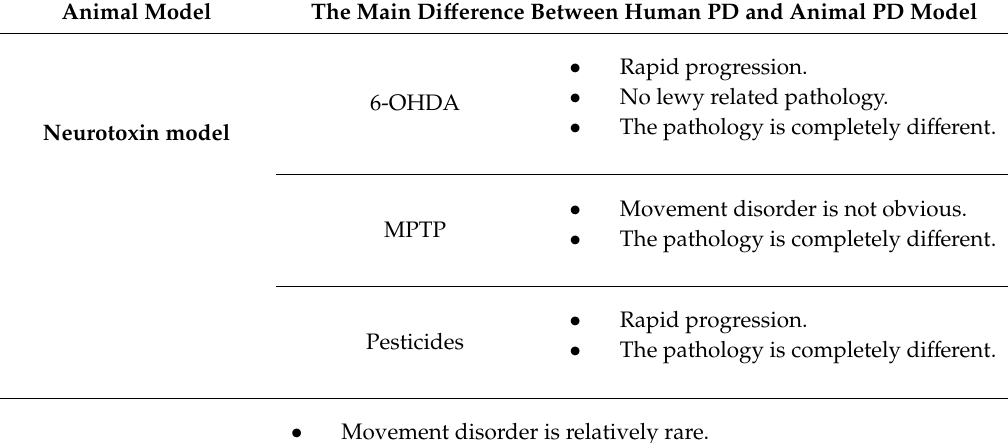
Figure 5. Trends in animal models that are used for PD research. The size of the Venn diagram indicates the number of studies that were conducted using each model since 2000. The neurotoxin models are most commonly used, and they are the easiest animals to handle. However, these rodent models are not appropriate for studies to clarify the pathology or to develop preventative treatment. Although genetic models and neurotoxin and genetic models would be relatively di ffi cult to handle, studies involving these models may be used to clarify the pathology or to develop preventative treatment. Table 1. The difference between human PD and animal PD model .